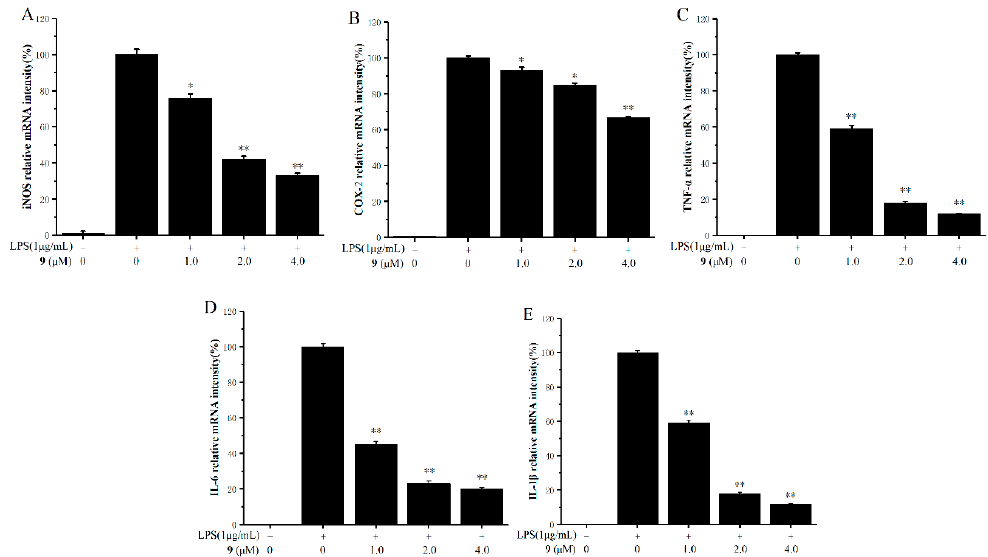
Figure 4. RAW 264.7 murine macrophage cells were pre-incubated for 12h, and then cells were pretreated with compound 9 at the indicated concentration for 1 h and incubated with LPS (1 μ g/mL) for 12h (real-time PCR). The effect of compound 9 on the mRNA expressions of inducible nitric oxide synthase (iNOS) ( A ), cyclooxygenase-2 (COX-2)( B ), tumor necrosis factor (TNF)- α ( C ), interleukin (IL)-6 ( D ), and IL-1 β ( E ) were detected by real-time PCR. The data represent the mean values ± SD of three experiments, * p < 0.05, ** p < 0.01 compared to LPS-treated group.